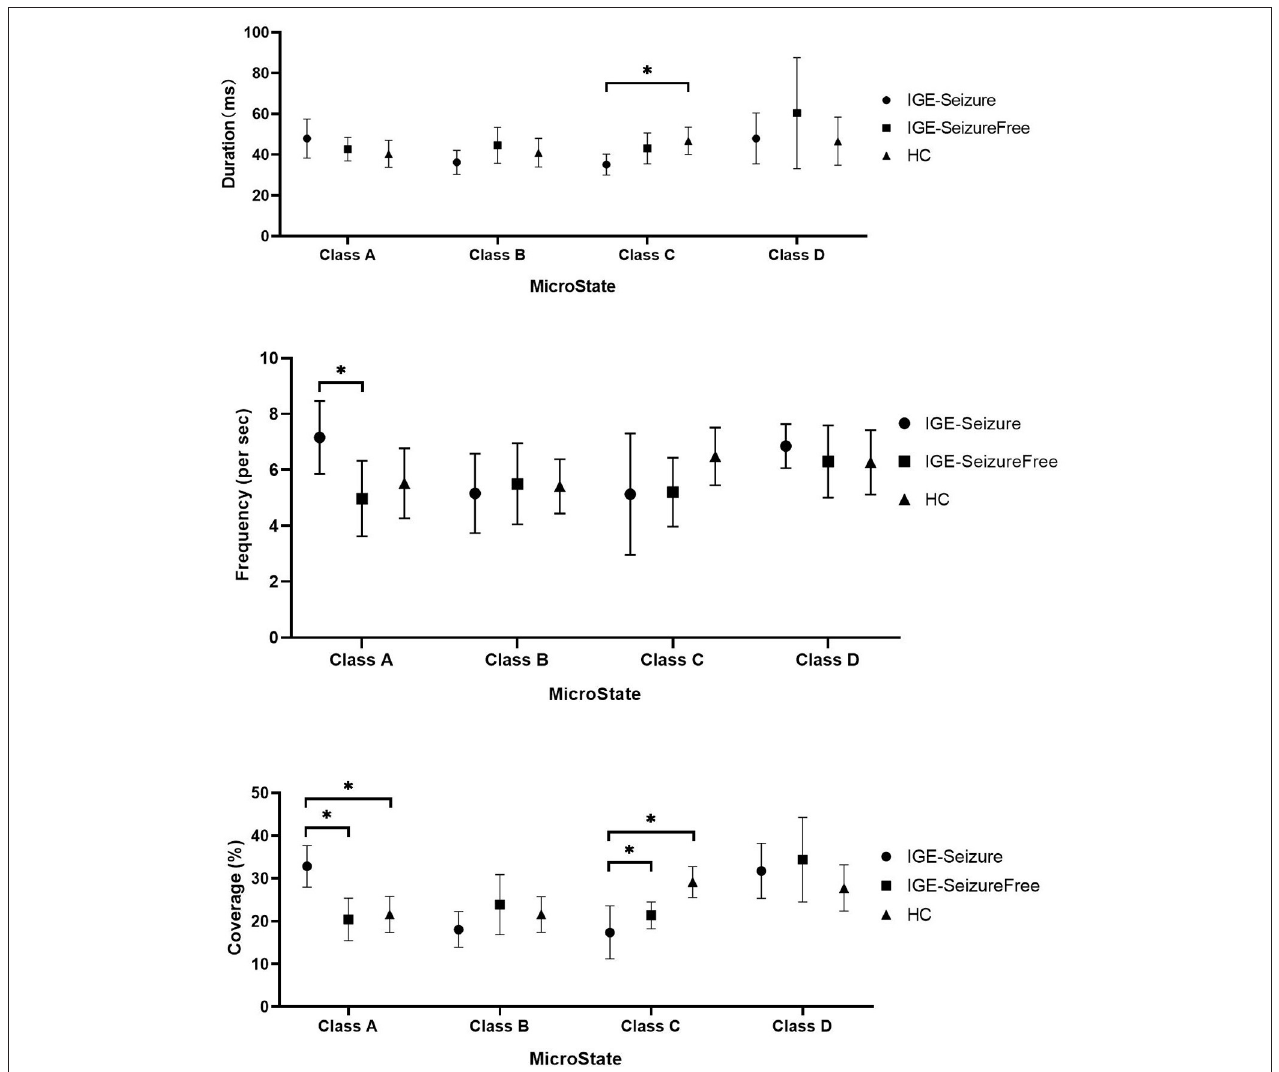
FIGURE 2 | Microstate characteristics between the three groups. * Means p < 0.004 ( Post hoc